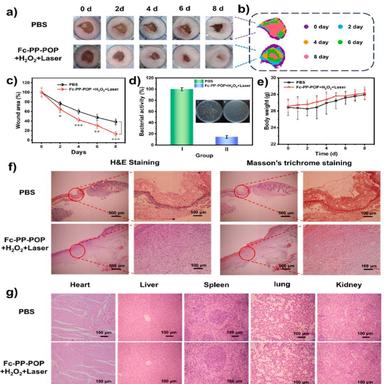
In vivo infected wound healing study. a) Representative pictures of wound tissues of two groups on days 0, 2, 4, and 8; b) Traces of wound-bed closure during 8 days for two groups; c) Wound healing rate for two groups during treatment (n = 5); d) Quantitative analysis bacterial colonies obtained from wound tissues after the two treatments. Inset: photographs of bacterial colonies; e) Body weight change curve for each group of mice; f) H&E and Masson's trichrome stained wound tissue slices for two groups on